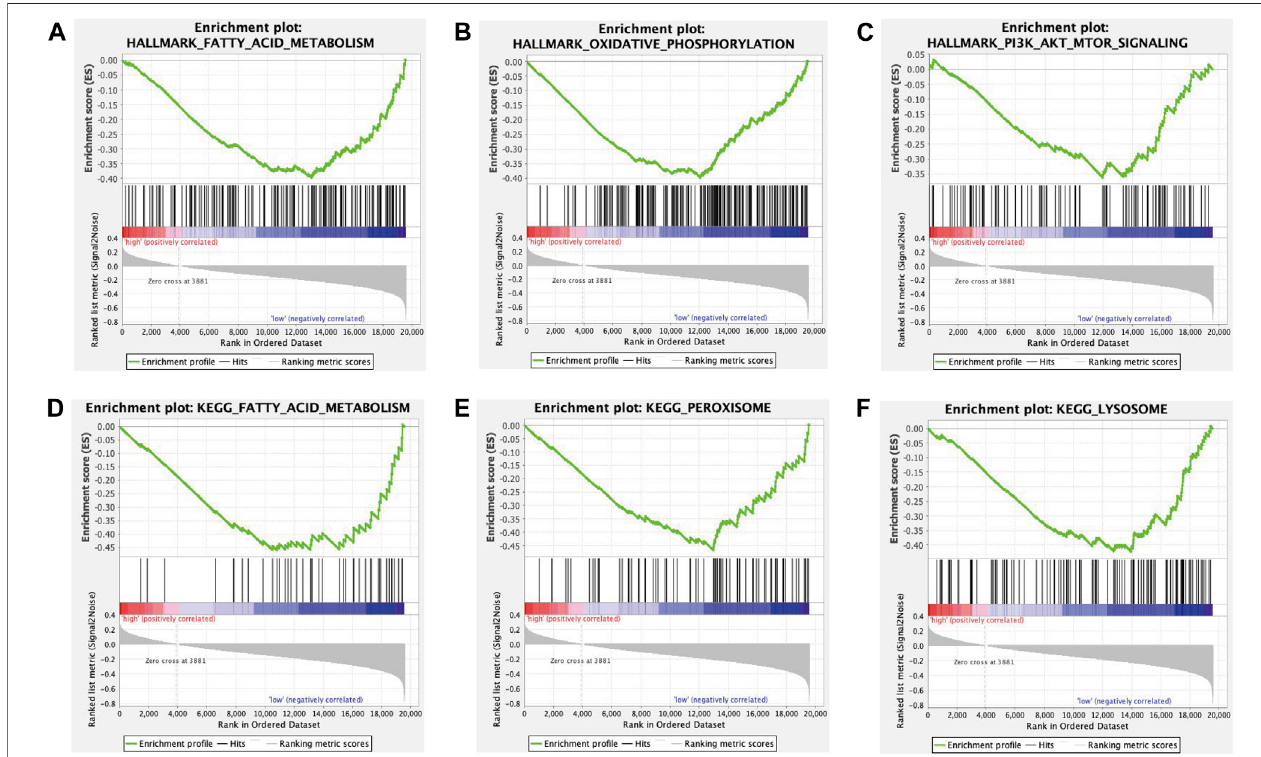
FIGURE 6 | GSEA illustrated that genes in the low-risk subgroup were signi fi cantly enriched in fatty acid metabolism (A, D) , oxidative phosphorylation (B) , PI3K- AKT-mTOR signaling (C) , peroxisome (E) and lysosome (F) .